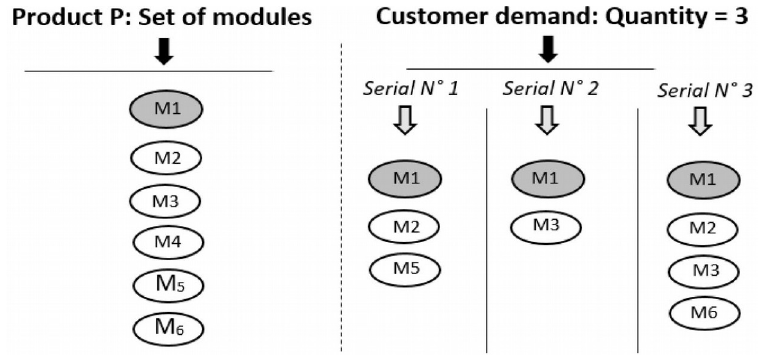
Figure 3. Modular product